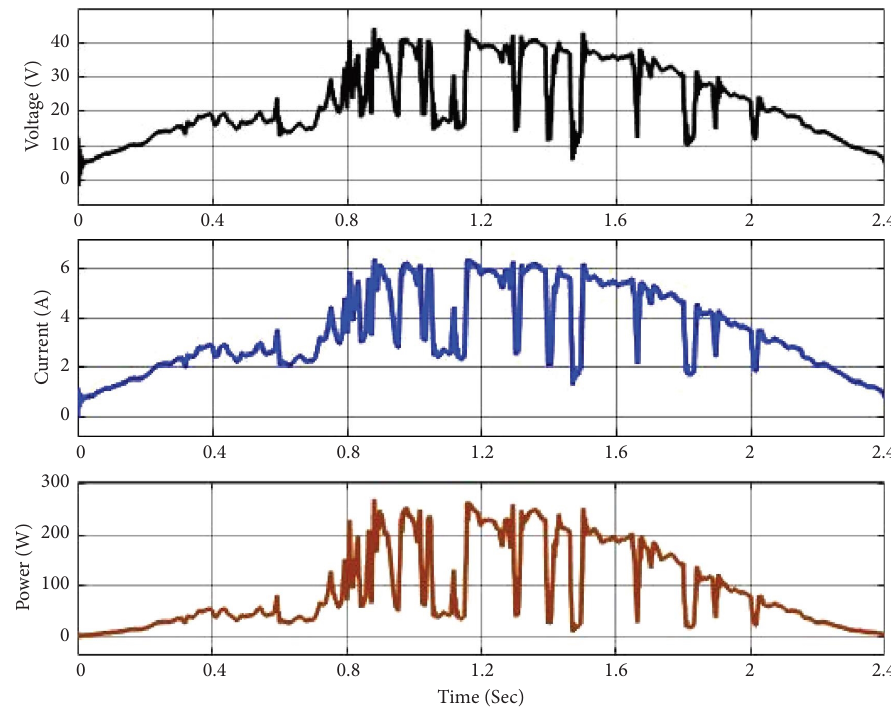
Figure 23: Input voltage, current, and power at Converter-1.